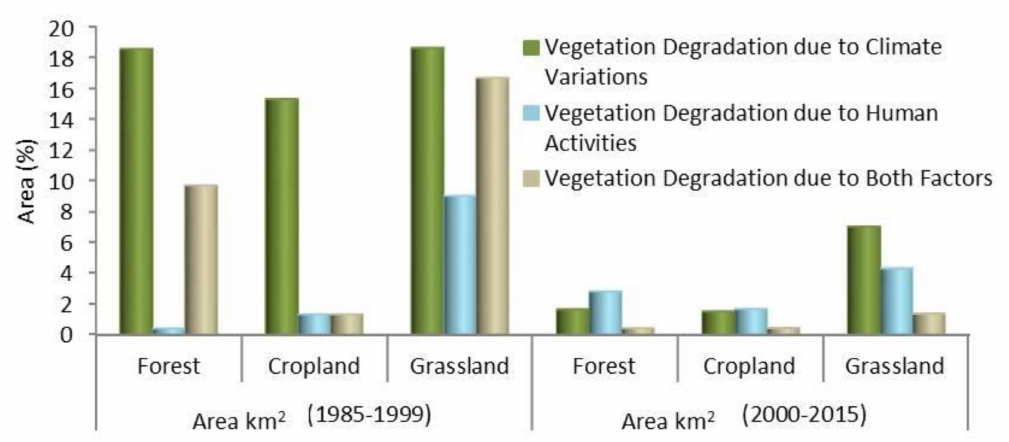
Figure 11. Relative contributions of climate and human activities for NPP degradation of three vegetation